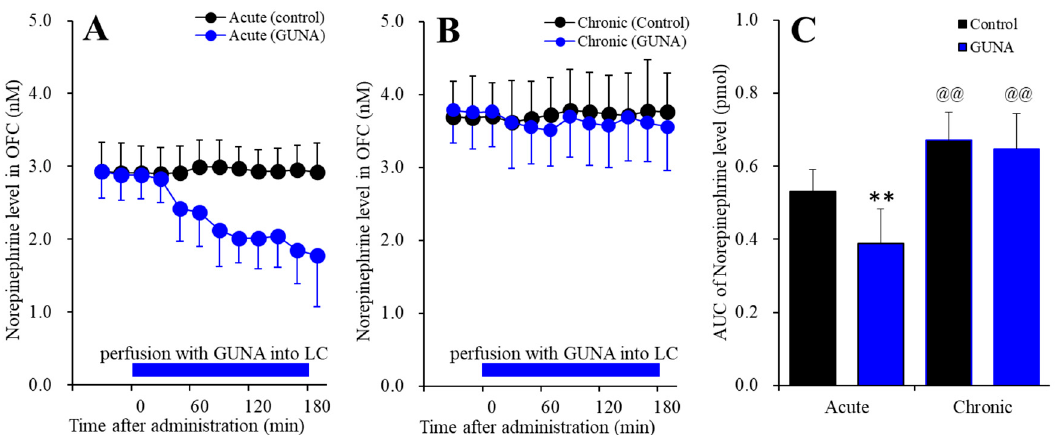
Figure 1. Effects of acutely local administration (perfusion with) 200 nM guanfacine into the locus coeruleus (LC) on extracellular norepinephrine level in the orbitofrontal cortex (OFC), after the systemically chronic administration of guanfacine (0 or 0.12 mg/kg/day for 14 days). Panel ( A ) indicates the effects of perfusion with 200 nM guanfacine into the LC after chronic administration of guanfacine (0 mg/kg/day) for 14 days (acute effects). Panel ( B) indicates effects of 200 nM guanfacine after systemically chronic administration of guanfacine (0.12 mg/kg/day) for 14 days (chronic effects). Ordinates: mean ± SD (n = 6) of extracellular norepinephrine level (nM), abscissa: time after administration of perfusion with guanfacine into the LC (min). Blue bars: perfusion of 200 nM guanfacine into LC. Panel ( C ) indicates the AUC 20–180 min values of extracellular norepinephrine level during perfusion with guanfacine (from 20 to 180 min). Ordinates: mean ± SD (n = 6) of AUC 20–180 min values of extracellular norepinephrine level (pmol). Black and blue columns indicate respective control and perfusion of guanfacine of AUC values of norepinephrine levels. When the effects of guanfacine were statistically significant compared using multivariate analysis of variance (MANOVA), the data were analysed using Tukey’s post hoc test. ** p < 0.01, compared with control. @@ p < 0.01: compared with acute effects of guanfacine.